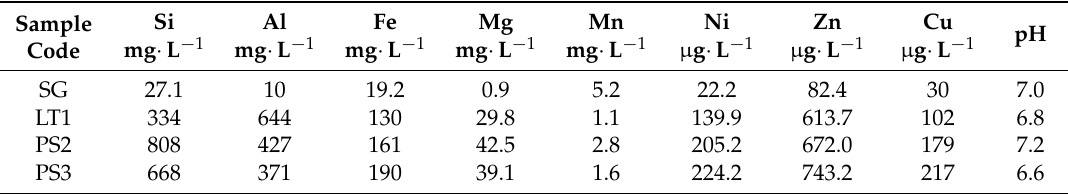
Table 1. Elemental composition and pH of the colloidal